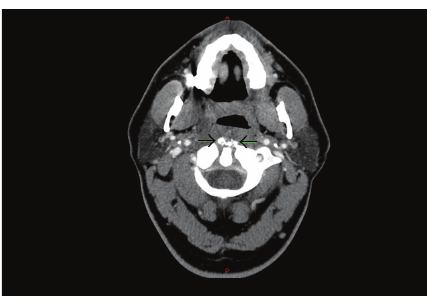
Figure 3: Axial CT of the neck with IV contrast on hospital day #4. Calcifications of the longus coli tendon are apparent (arrows).